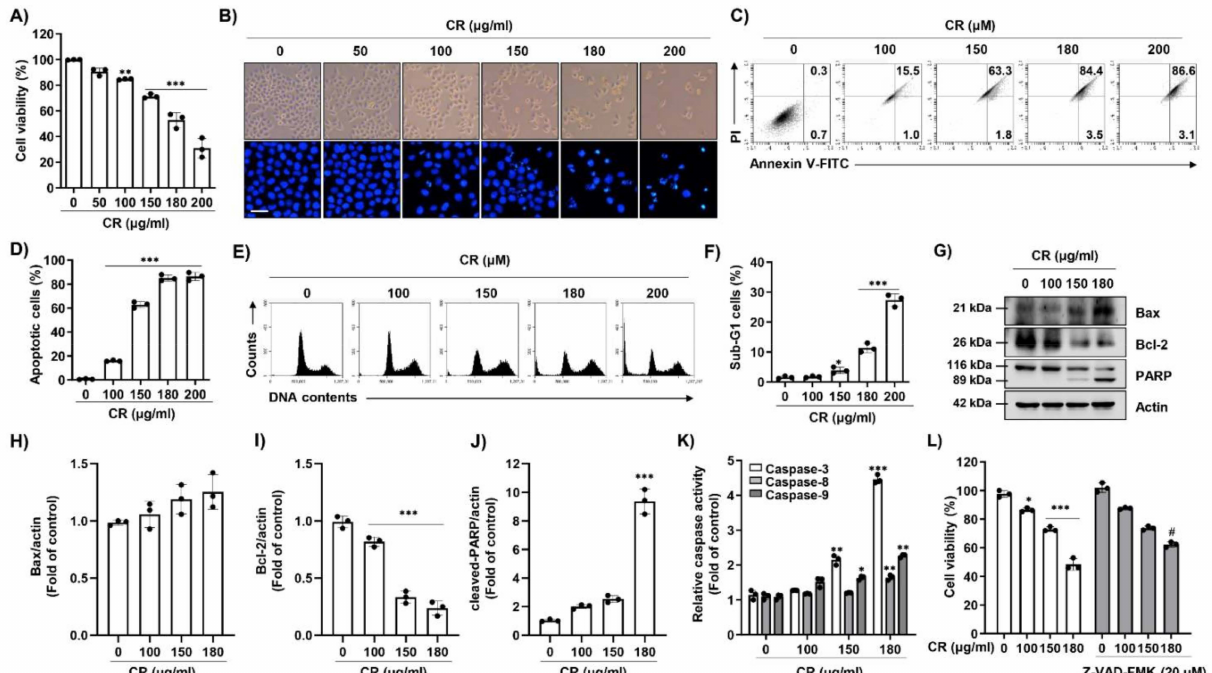
Figure 1. Coptidis Rhizoma ethanol extract (CR) promotes caspase-dependent apoptosis in Hep3B cells. Cells were treated with the indicated concentrations of CR for 24 h. ( A ) After 24 h, we added 0.5 mg/mL of 3-(4,5-dimethylthiazol-2-yl)-2,5- diphenyltetrazolium bromide (MTT) solution for 2 h at 37 ◦ C. The data are expressed as mean ± standard deviation (SD) of three independent experiments. ** p < 0.01 and *** p < 0.001 when compared to control. ( B , Top panel) Cell morphology was observed by a phase-contrast microscope at 50 × magnification. ( B , Bottom panel) After 24 h, cells were harvest and stained with 2.5 µ g/mL of 4 (cid:48) ,6 (cid:48) -diamidino-2-phenylindole (DAPI) solution for 20 min, and washed with PBS and then detected using a fluorescence microscope. Scale bars; 30 µ m. ( C ) After treatment with CR for 24 h, cells were collected and stained with annexin V-fluorescein isothiocyanate (FITC) and propidium iodide (PI), and apoptosis-positive cells were measured by flow cytometry. ( D ) The frequencies of apoptosis-positive cells were quantified by expressing the number of annexin V + cells ( n = 3). *** p < 0.001 compared to control. ( E ) After 24 h of CR treatment, cells were collected and stained with PI and sub-G1 cells were detected by flow cytometry. ( F ) The apoptotic cells were quantified by expressing the sub-G1 cells ( n = 3). * p < 0.05 and *** p < 0.001 compared to control. ( D and F ) The percentages of apoptotic cells were quantitated by expressing the numbers of annexin V + cells and sub-G1 cells ( n = 3). * p < 0.05 and *** p < 0.001 compared to control. ( G ) After treatment with CR for 24 h, cells were lysed, and equal amounts of proteins were analyzed using Western blot analysis to detect the expression of Bcl-2 associated x-protein (Bax), Bcl-2, and poly-ADP ribose polymerase (PARP). Actin was used as a loading control. ( H – J ) Bar graphs indicate the relative band density in western blot analysis ( n = 3). *** p < 0.001 compared to control. ( K ) After 24 h, cells were harvested and incubated with caspase-3, -8, and -9 substrates. The activities were measured by an enzyme-linked immunosorbent assay (ELISA) reader ( n = 3). * p < 0.05, ** p < 0.01, and *** p < 0.001 compared to control. ( L ) Cells were pre-treated with or without 20 µ M of benzyloxycarbonyl-Val-Ala-Asp (OMe) fluoromethylketone (Z-VAD-FMK) for 1 h, and treated with CR for 24 h. Cells were treated with MTT solution for 2 h at 37 ◦ C. Cell viability was measured by the MTT assay ( n = 3). * p < 0.05 and *** p < 0.001 compared to control, and # p < 0.05 compared to CR-treated